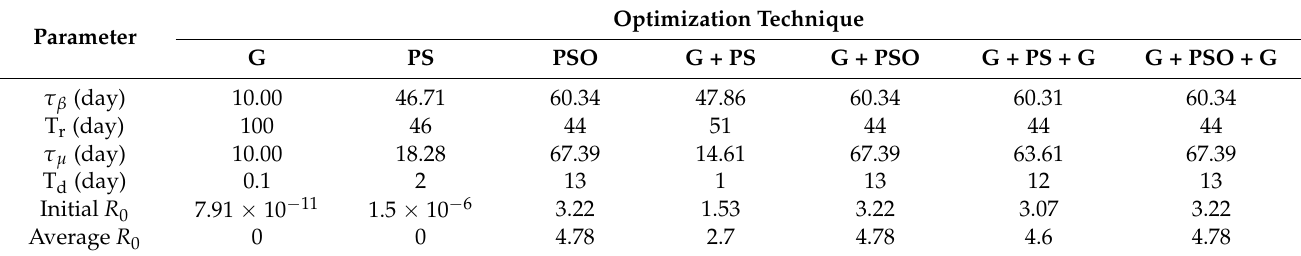
Table 2. Spread of COVID-19